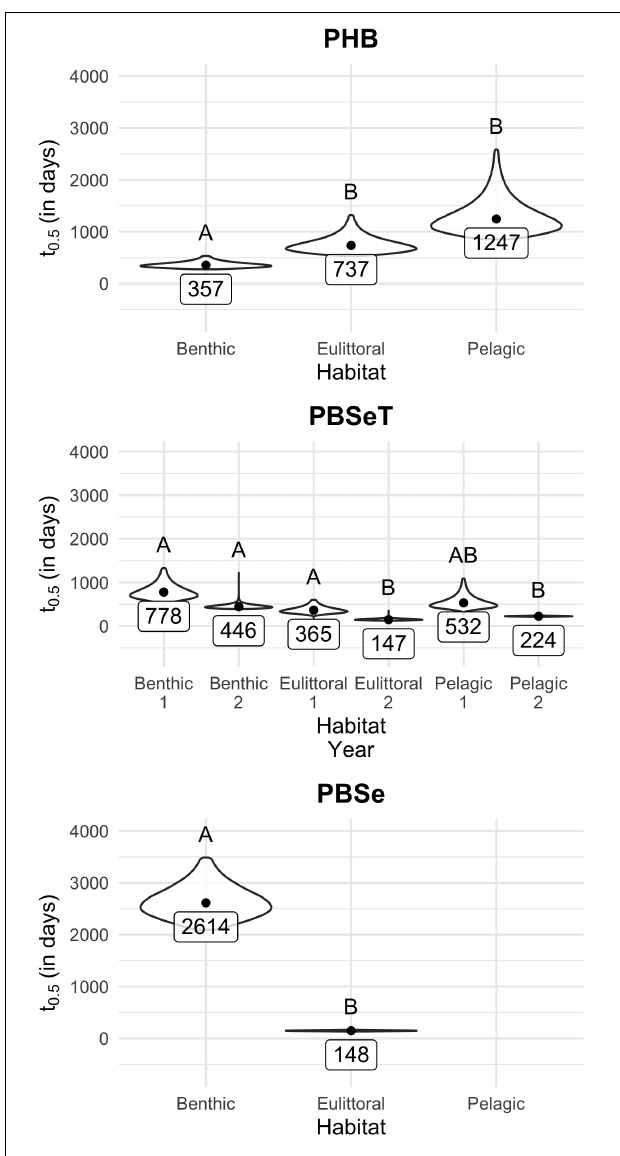
FIGURE 5 | Mesocosm experiments with Mediterranean Sea water and sediment: Disintegration half-lives t 0 . 5 of PHB, PBSeT, and PBS. Monte Carlo simulations of half-life for tested polymers in three habitats (on the seafloor at the sediment-seawater interface (benthic), the beach (eulittoral), and the water column (pelagic) scenario). Shown is the distribution of the centered 95 percentiles of the simulations as violin plots. The dot in the center of each violin plot represents the half-life as calculated from the model coefficients, and the value is given in the box below. Letters above the violin plot represent the results of the multiple comparisons. Different letters indicate significantly different